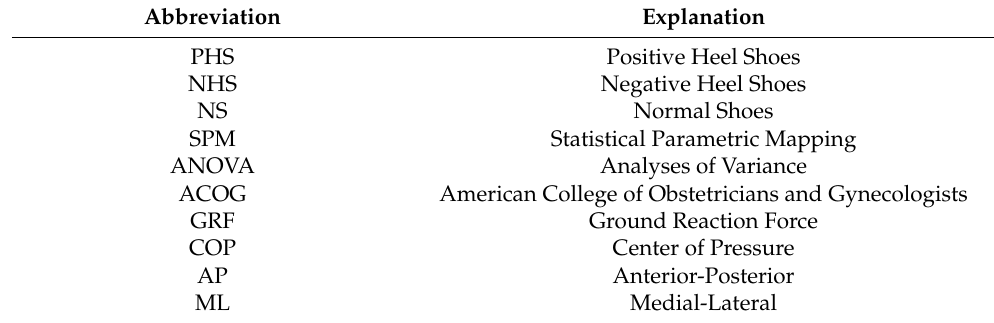
Table 1. List of abbreviations and acronyms used in this article. Abbreviation